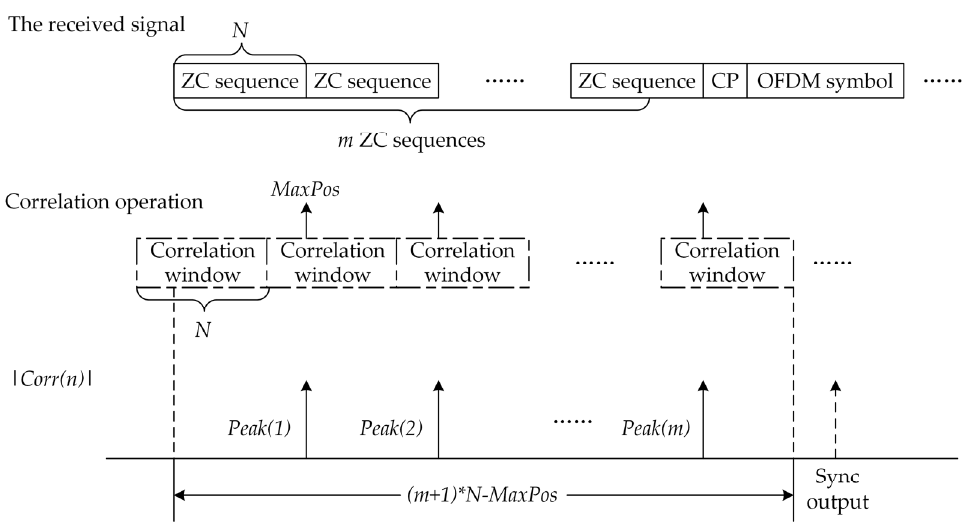
( ) Corr n . Figure 4. The amplitude variation of the correlation value Corr ( n )